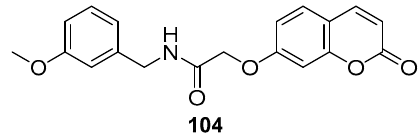
Figure 38. 7-substituted coumarin as blockers of NF- κ B signaling pathway.